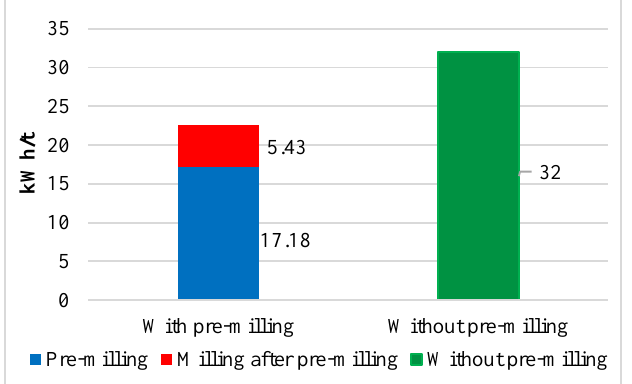
Fig. 8. Electricity and time efficiency comparisons in operational mode with and without the pre-milling